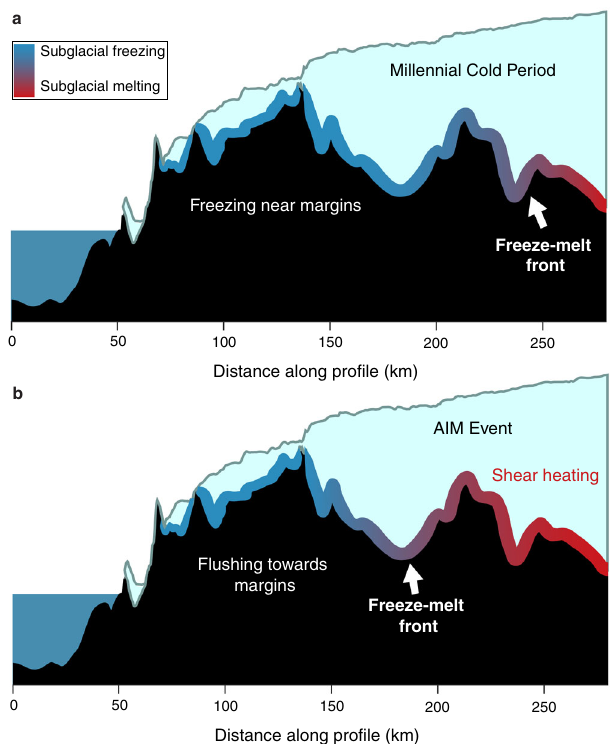
Fig. 6 | Schematic of subglacial hydrologic change during millennial climate cycles. a Schematicof subglacialhydrologicsystemsduringamillennial-scalecold period. During this time marginal aqueous systems are frozen and isolated from interior meltwater inputs. b Schematic of subglacial hydrologic systems during a millennial-scale warm period (AIM). During these events accelerated ice drives basalshearheating,whichallowsthebasalfreeze-meltfronttomigratetowardsthe ice sheet margin. This process allows subglacial meltwater from the ice sheet interior to fl ush towards the margin. Total distance of horizontal migration of the freeze-melt front is unknown but must be >10km based on precipitate collection location and inferred location of